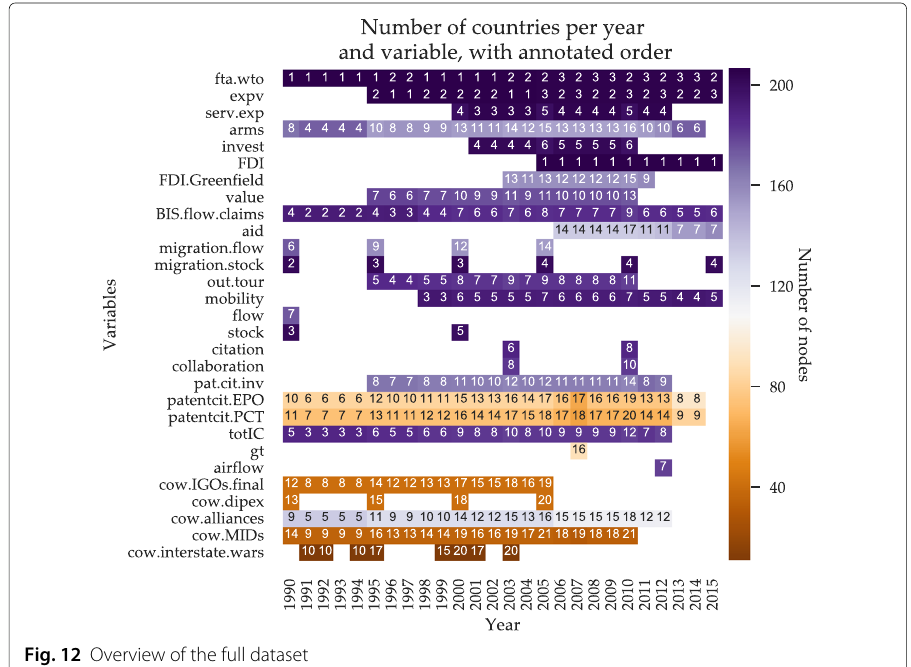
Fig. 12 Overview of the full